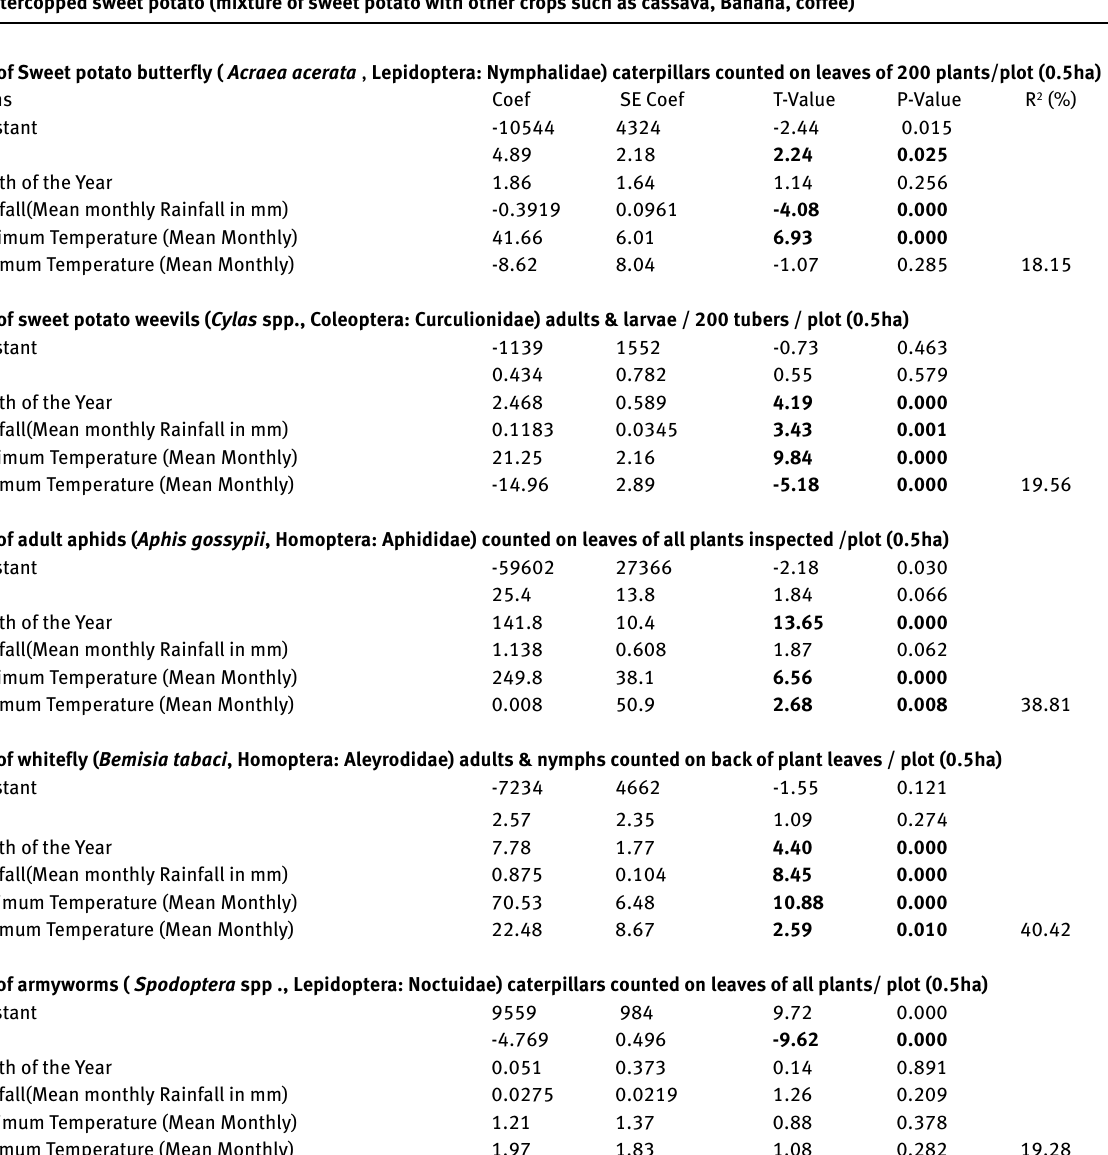
Table 3. Multiple regressions to test the influences of climatic factors (Year of data collection, Month of the year, Monthly rainfall, Maximum &Minimum temperatures) on the dynamics of the population density of sweet potato pests and virus infection pressure (number of sweet potato leaves presenting symptoms of virus infection in the field) from 2005 to 2015, South-Kivu Province, eastern DRCongo A. Intercopped sweet potato (mixture of sweet potato with other crops such as cassava, Banana,